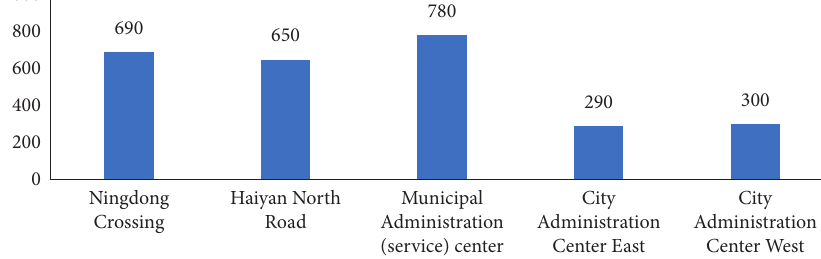
Figure 6: Distances between nearby bus stops and Fuqing North Road Station.